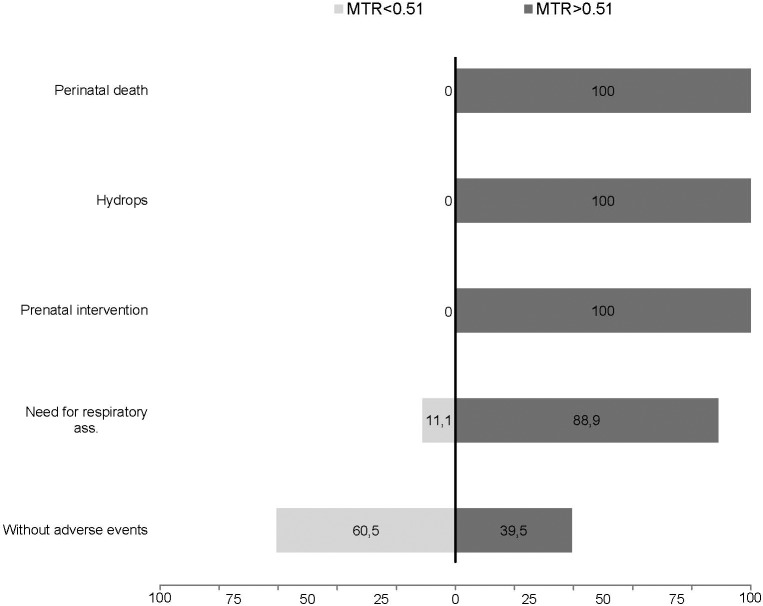
Detectionrate in % of adverse events (perinatal death, hydrops, prenatal intervention or need for respiratory assistance) at a cutoff of 0.51 mass-to-thorax rate (MTR) in comparison to fetuses without adverse events.